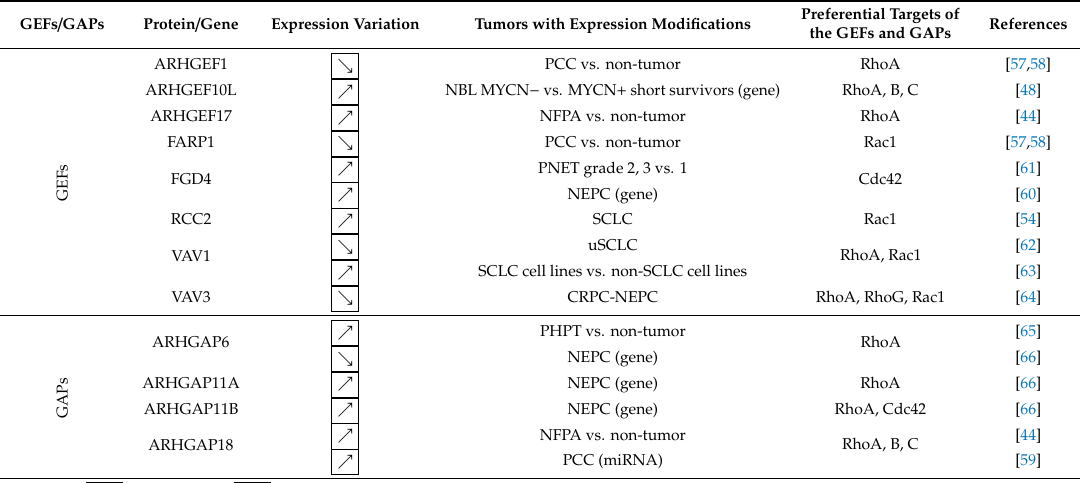
Table 2. Expression level changes of Rho GEFs and Rho GAPs in NETs. Expression Variation